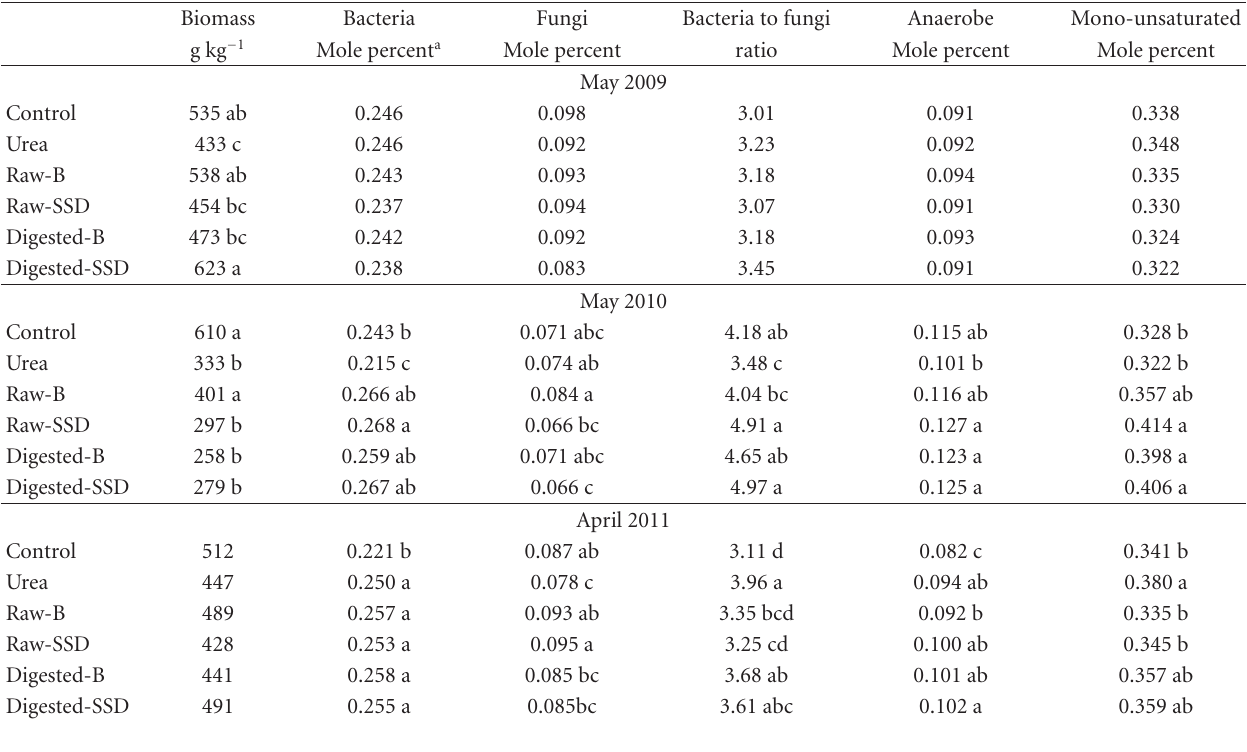
Table 9: Soil microbial analyses from field plots in the spring,